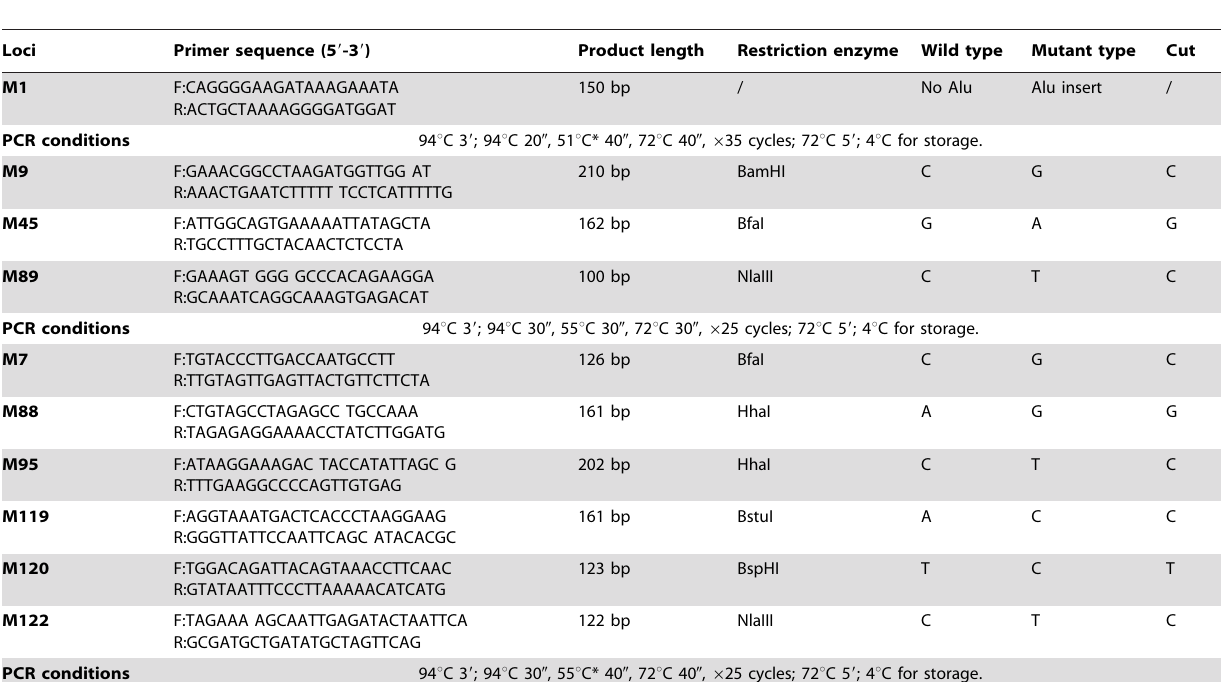
Table 6. Primer sequences and amplification conditions for 10 Y-chromosome SNPs.